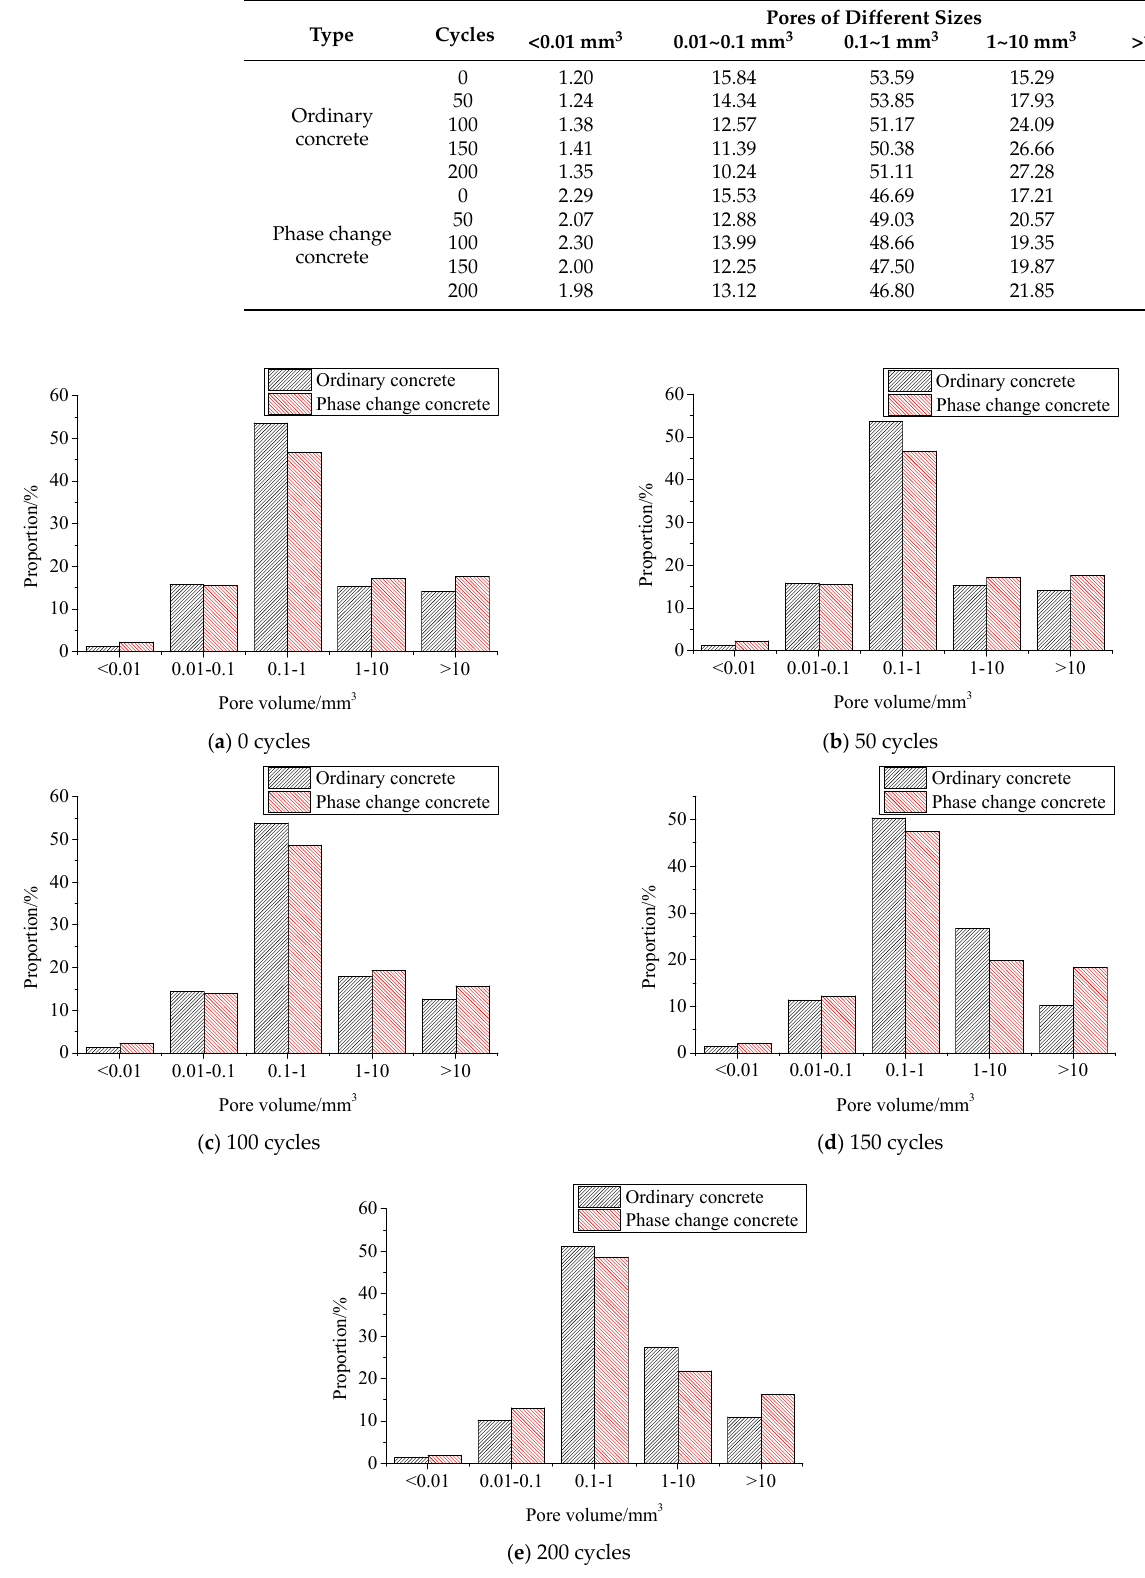
Table 15. Volume proportion of pores in different size ranges in concrete (%).